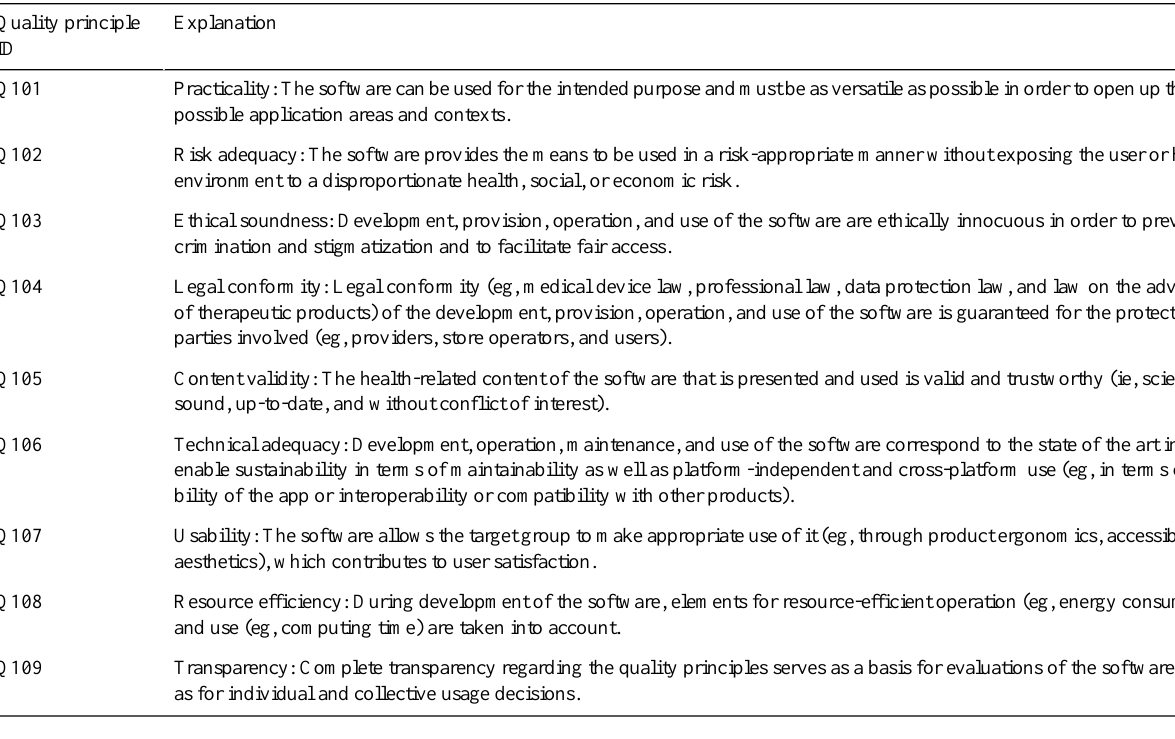
Table 2. The nine quality principles and their explanations used for the initial assessment (ie, Q1 a ), following the definitions in Albrecht et al [9]. ExplanationQuality principle